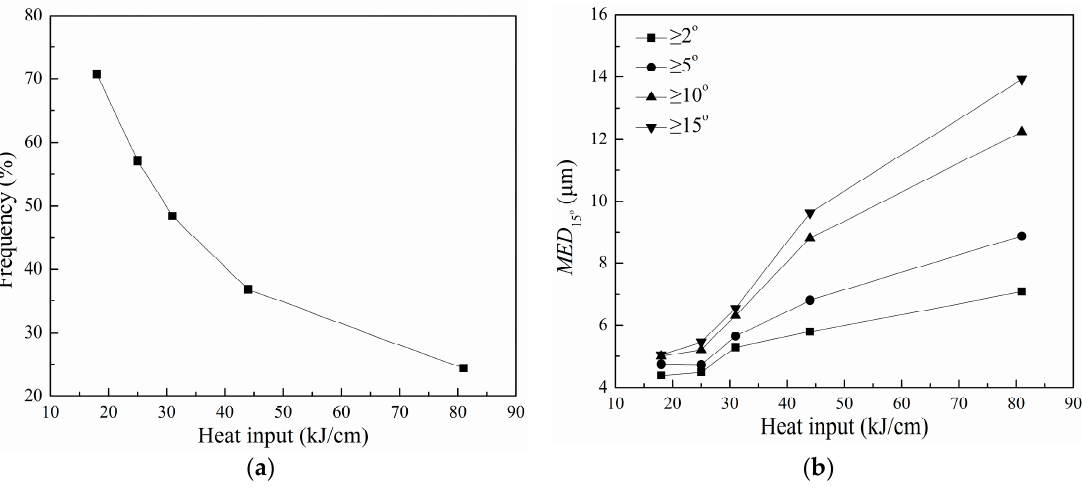
Figure 9. ( a ) Frequency of high angle grain boundaries (misorientation: ≥ 15°); and ( b ) EBSD-determined mean effective grain size (for tolerance angles of 2–15°) as a function of the heat input.